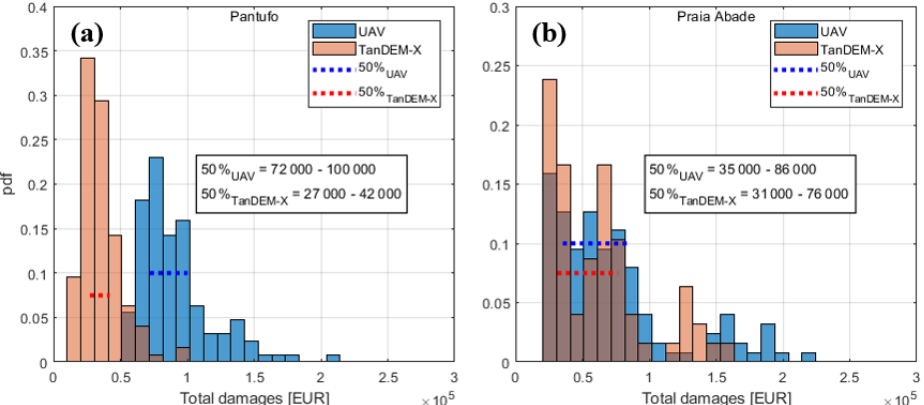
Figure 9. Impact of using global DEMs versus local DEMs. Histograms of damages from all 1260 simulations of the present scenario, using a single DEM dataset, the UAV-derived scenario (blue histograms) and TanDEM-X (orange histograms) for Pantufo (a) and Praia Abade (b) . Dotted lines indicate the width of the 50% confidence interval. Damages are expressed in euros